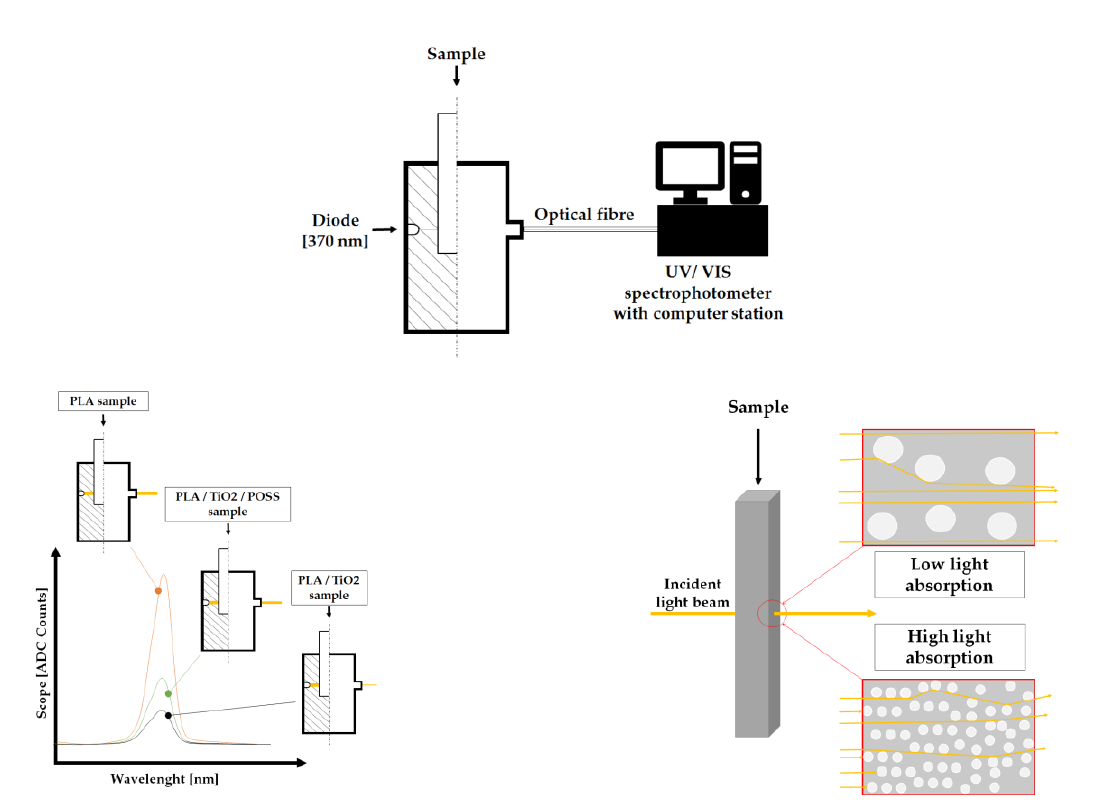
Figure 9. Measurement scheme of Relative hiding power